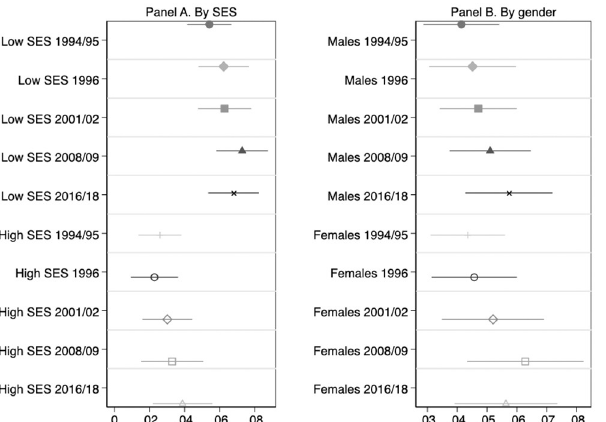
Fig 5. Association between BMI polygenic scores and Log(BMI) along the life-cycle: Patterns by gender and socioeconomic background. Add Health Cohort . This Figure summarizes the results of estimating Eq 2 on the balanced sample of 2,730 Add Health cohort members described in Table 2 by parental socioeconomic status (SES, in Panel A) and by gender (Panel B). The dependent variable is Log(BMI). OLS coefficient estimates of β 1 as well as their associated 95% confidence intervals are depicted. All regressions include age, age squared, and the first 10 principal components of the full matrix of genetic data. Regressions by SES (in Panel A) also include a female dummy as a covariate. Low and High SES individuals are those whose parental socioeconomic status is below and above the median, respectively. Standard errors are clustered at the school level. Longitudinal weights are used.